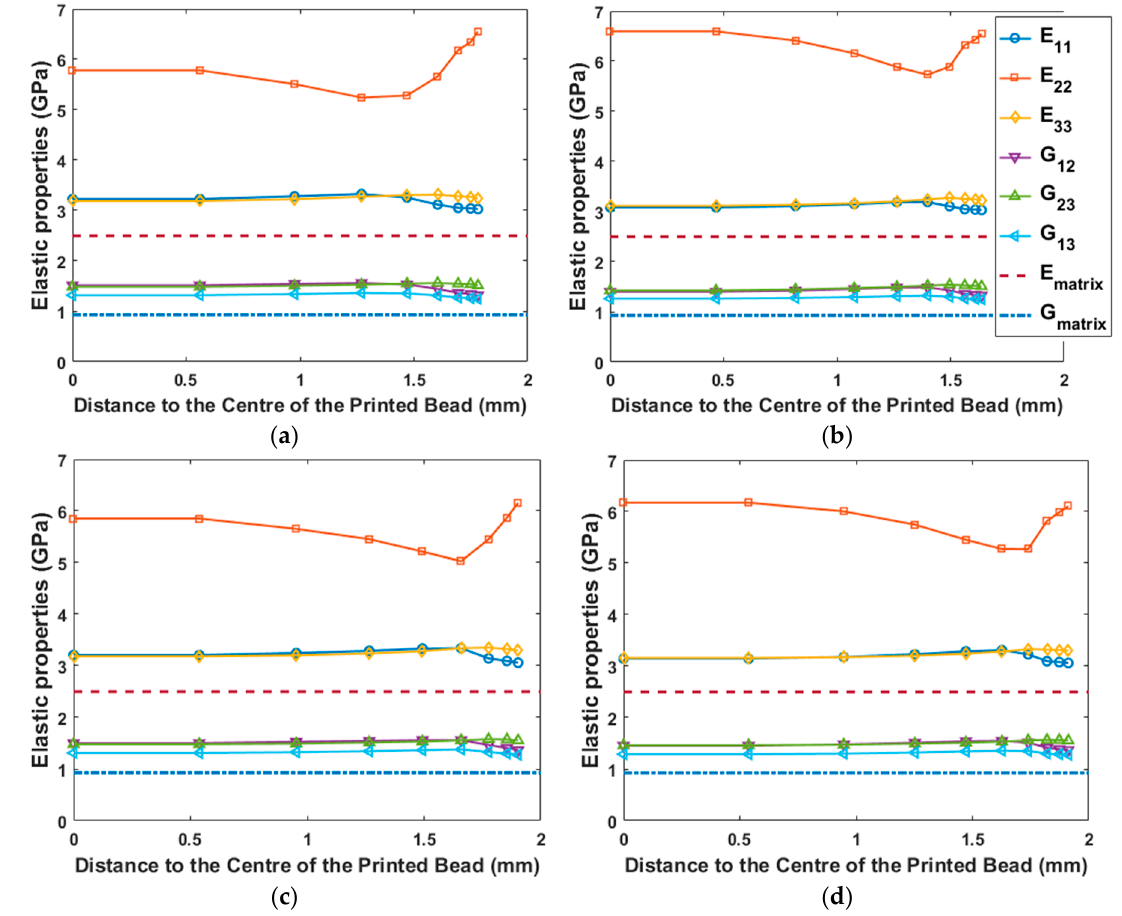
Figure 11. Elastic properties across the printed extrudate computed with flow kinematics obtained by ( a ) the Newtonian model; ( b ) the Power law model; ( c ) the PTT model; ( d ) the Simplified Viscoelastic (SV) model. Note that the legend shown in ( b ) works for all four sub-figures.